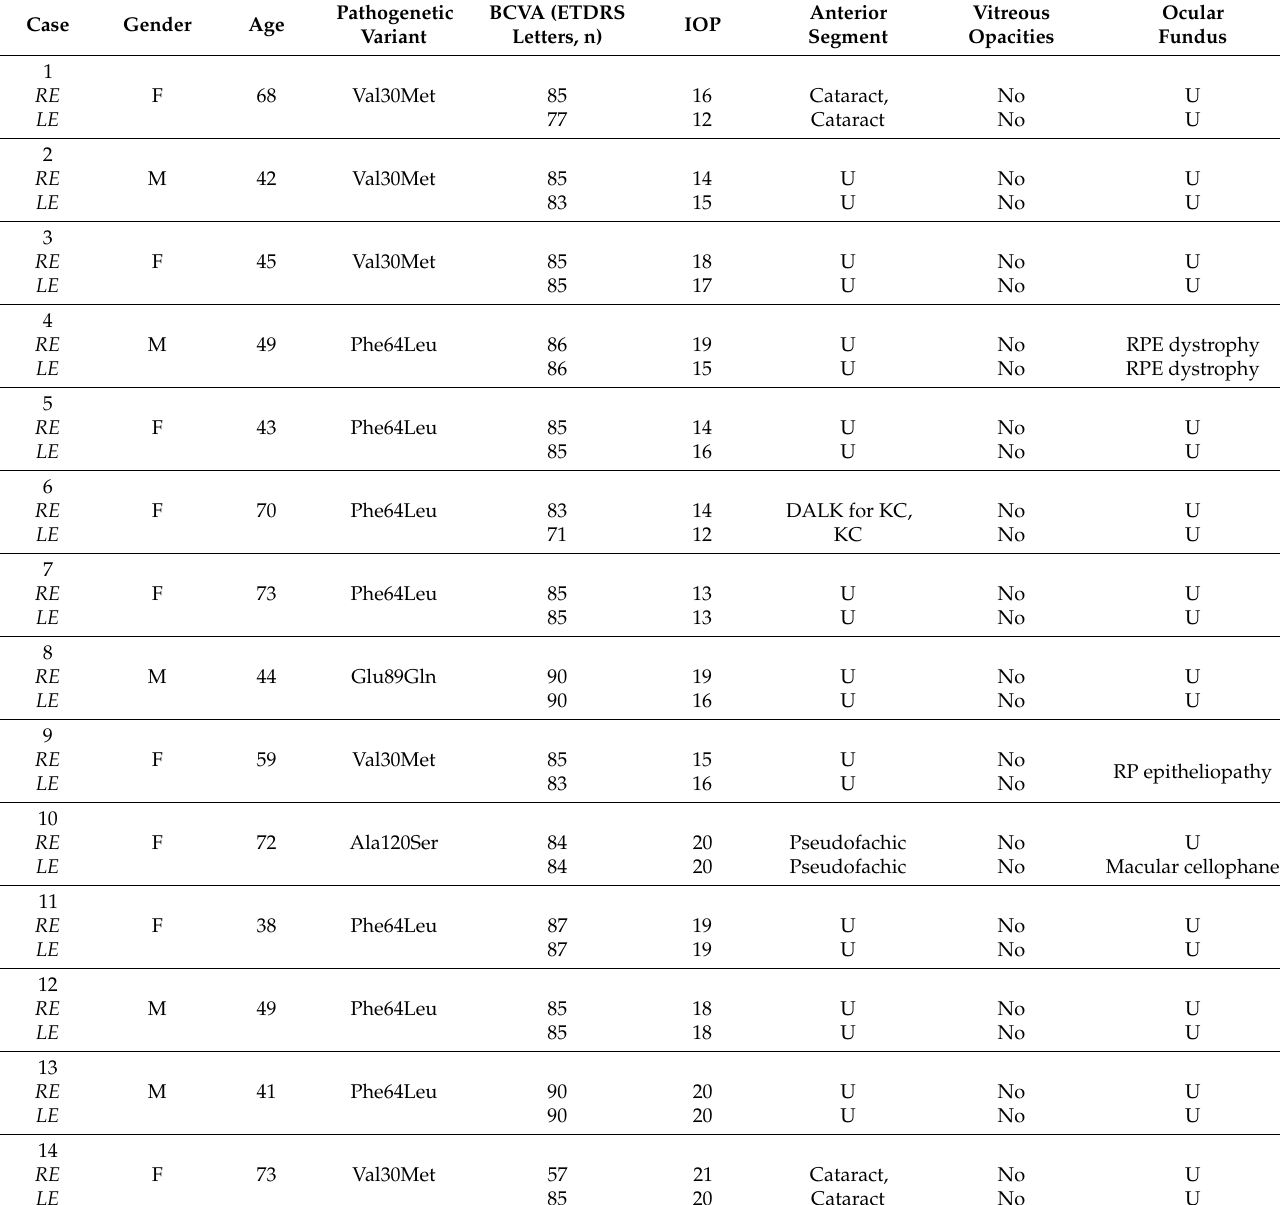
Table 1. Demographic, clinical and ophthalmological